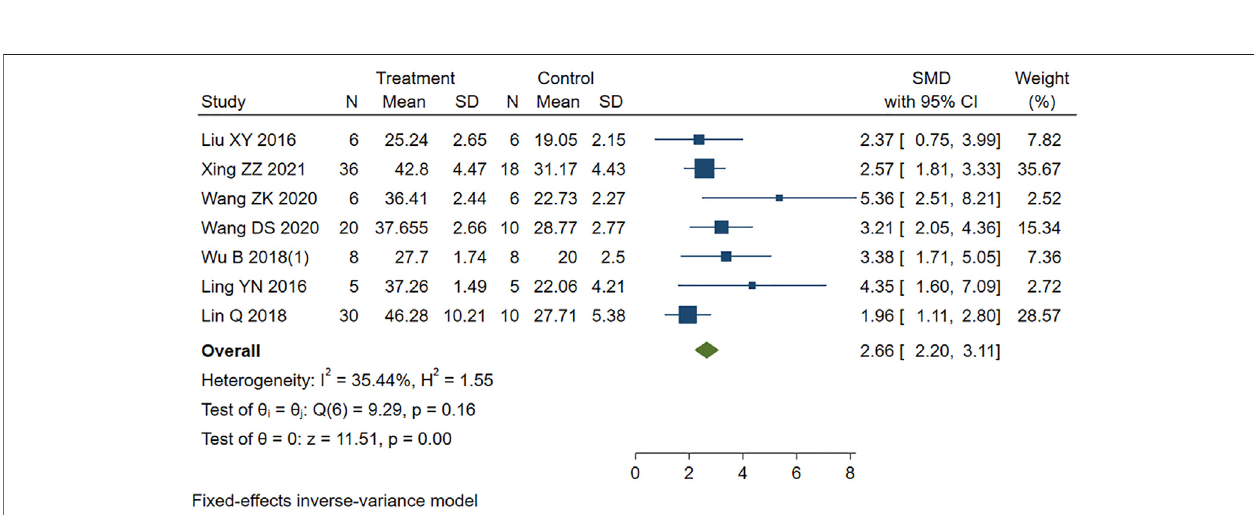
FIGURE6| ForestplottostudytheeffectofPEonleftventricular fractionalshortening (LVFS).PEimprovedLVFSinMIRIanimalscomparedtocontrolgroup(SMD =2.66,95%CI:2.20to3.11, p < 0.001).Thedarksquaresrepresentthestandardizedmeandifference(SMD)foreachstudy.Thediamonds representthepooledSMD. 95% of the CIs are indicated by lines. The analysis was conducted using a fi xed-effects model.